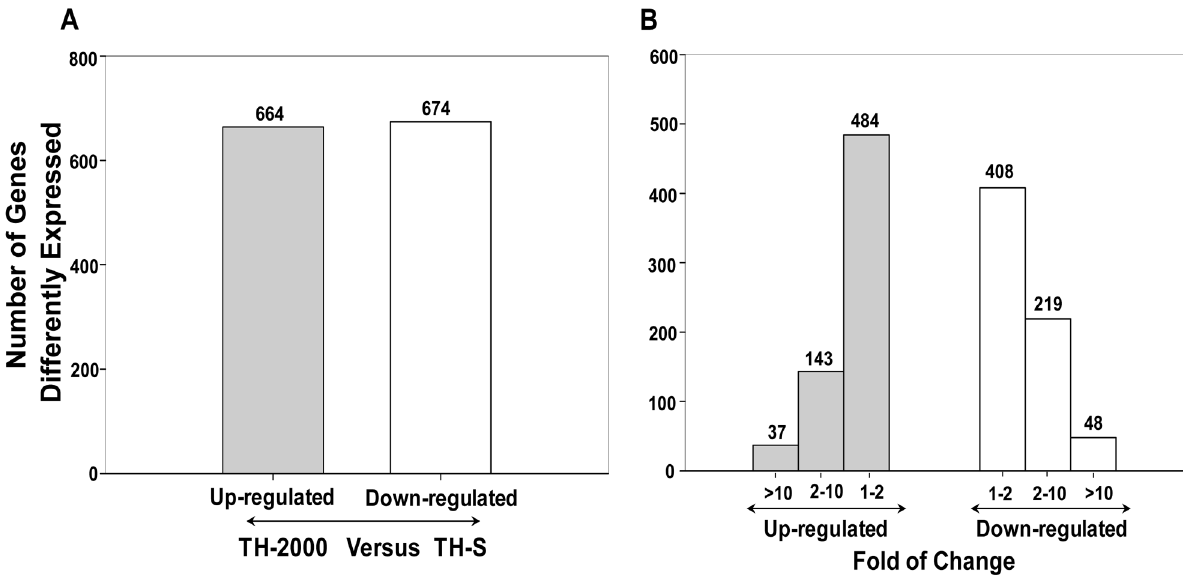
Figure 1. Differentially expressed genes between thiamethoxam resistance and susceptible B.tabaci . (A) All 338 differentially expressed genes between the two B. tabaci strains were selected with a cutoff value of FDR # 0.001 and |log 2 Ratio| $ 1. (B) The distribution of differentially expressed genes based on fold of changes.